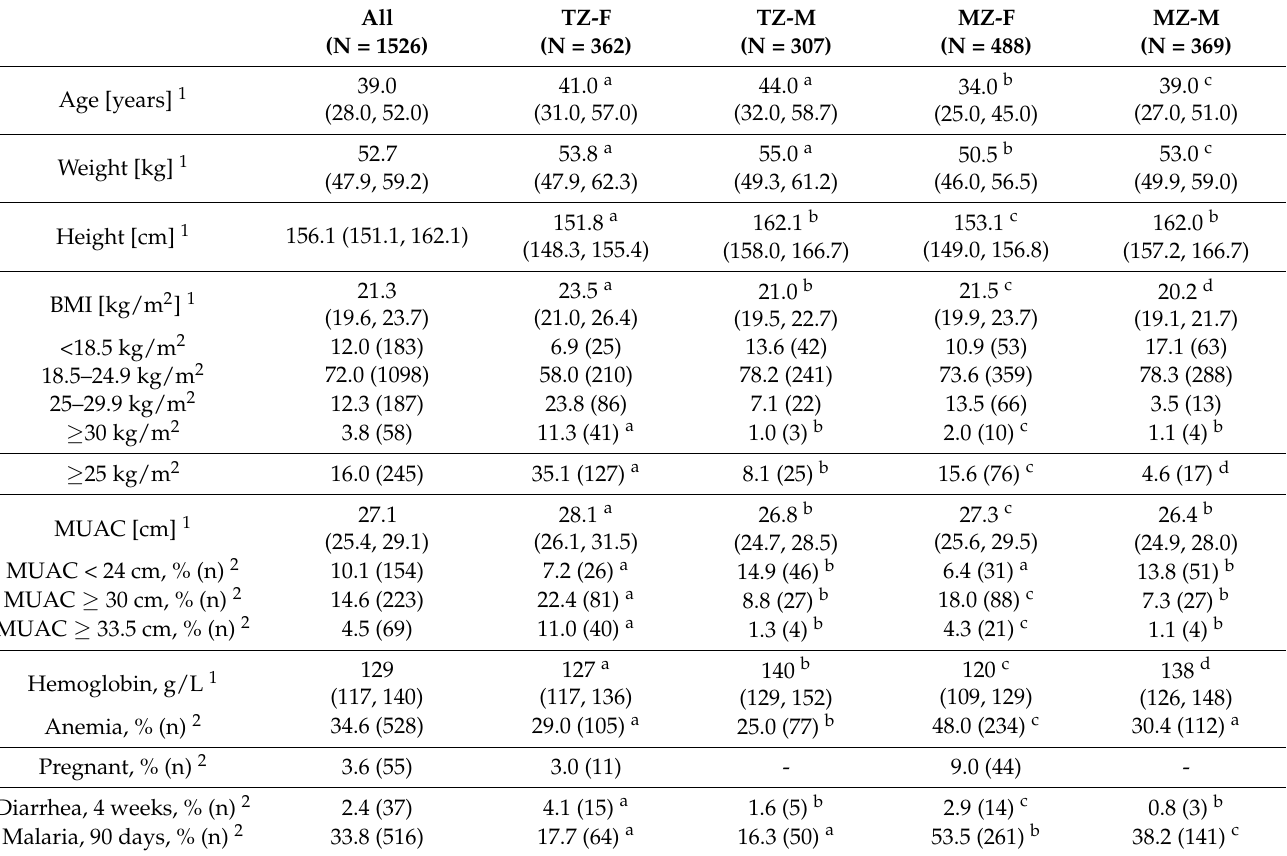
Table 1. Characteristics and anthropometrics of the study population.